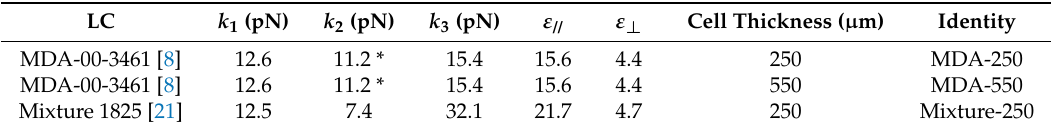
Table 1. Material constants and parameters of the three types of TN- liquid crystal LC terahertz (THz) phase shifters (* value calculated using the ratio k 2 / k 1 = 0.89 [22]). ε 0 is the vacuum permittivity 8.85 × 10 − 12 F/m.